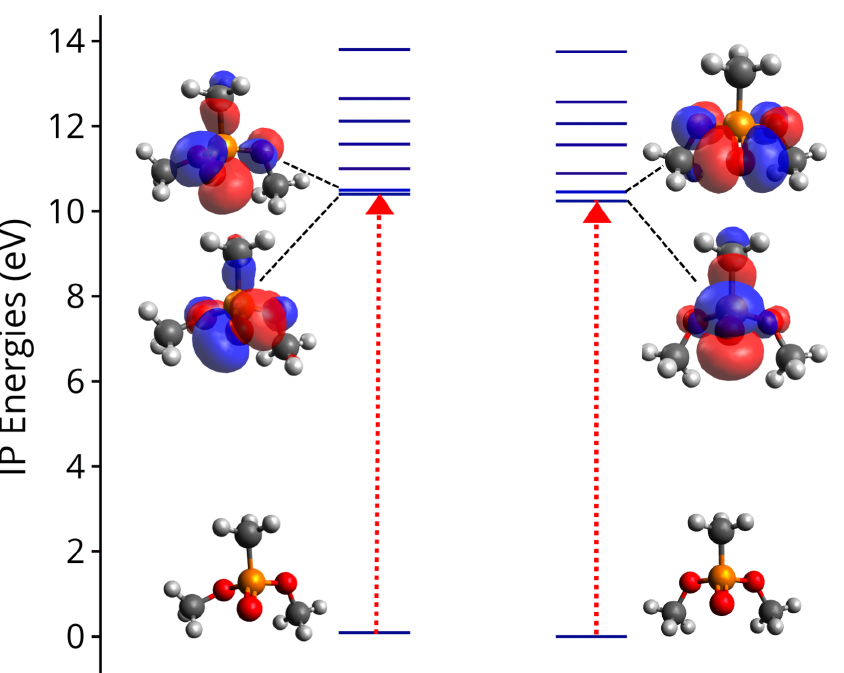
Figure 3. Vertical ionization potentials (IPs) of DMMP calculated at the EOM-IP-CCSD/6-311+G(d) level of theory for the C 1 conformer (S 0,C All energies are in eV and are plotted with respect to S 0,C the hole of the first two cationic states are also shown, while the Dyson orbitals for the other states are shown in SM (Figures S4 and